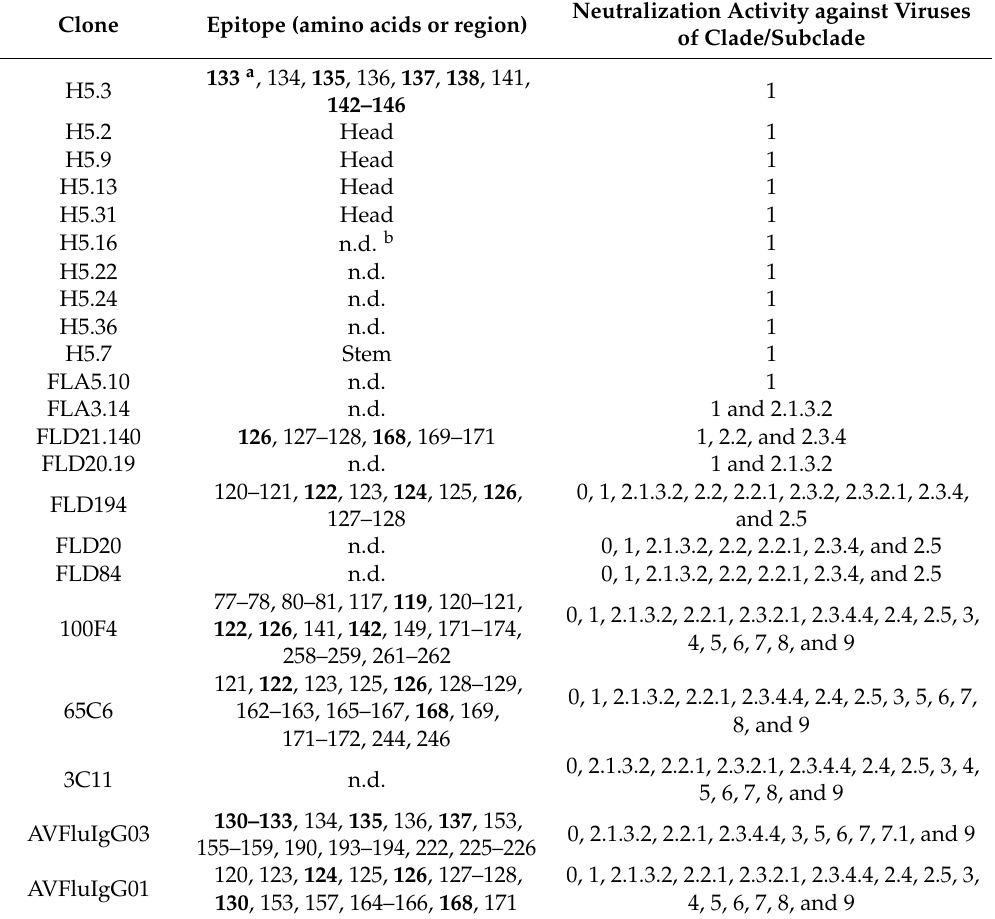
Table 1. The epitope and neutralizing breadth of the previously identified 22 human monoclonal antibodies (mAbs). Clone Epitope (amino acids or